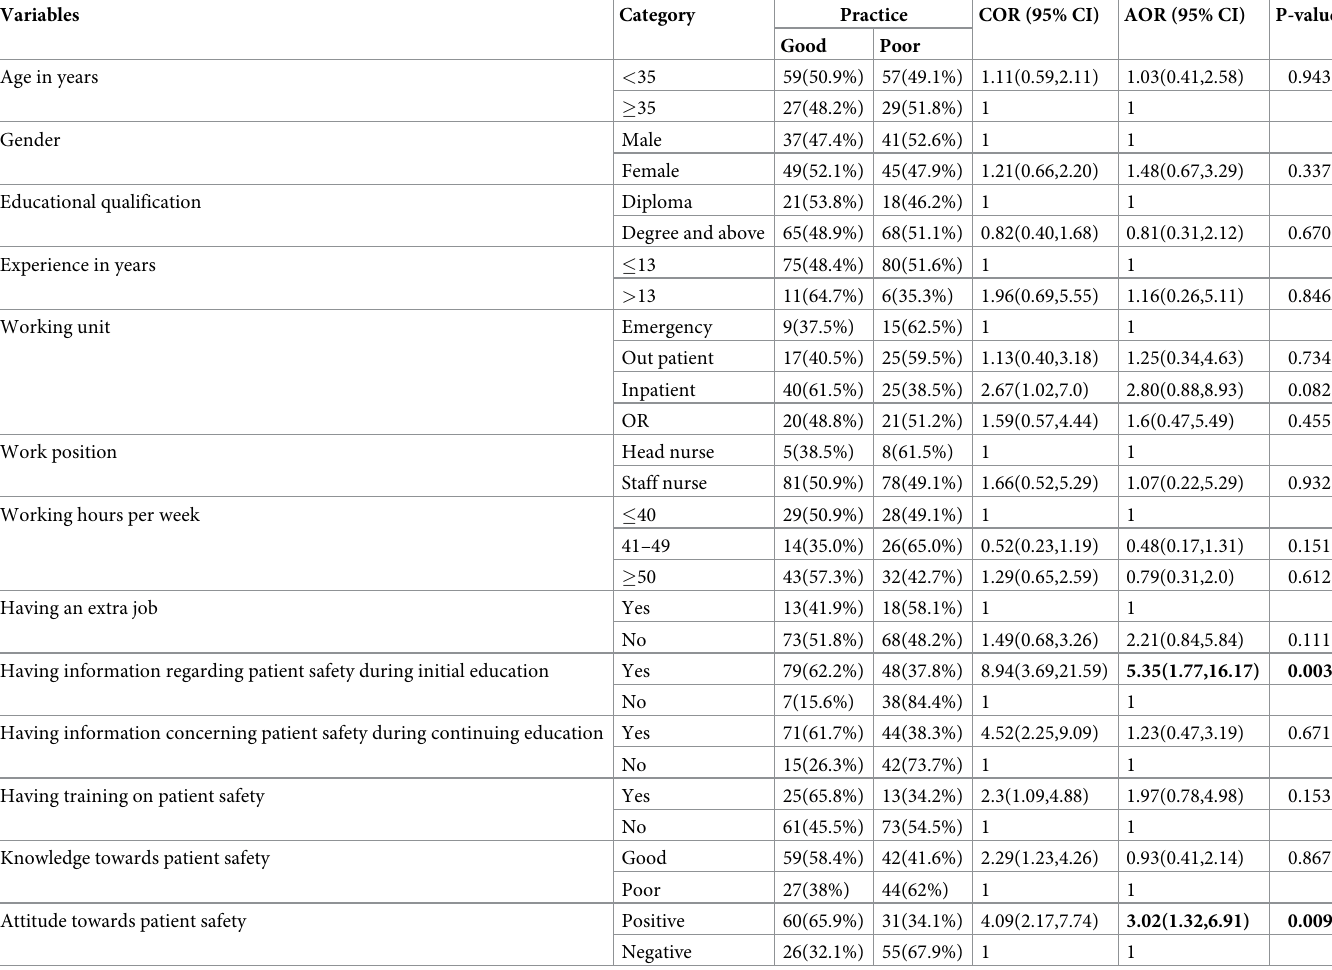
Table 5. Bivariable and multivariable logistic regression analysis of factors associated with practice towards patient safety among nurses working at Asella Referral and Teaching Hospital, Asella, Ethiopia, 2021, [n =